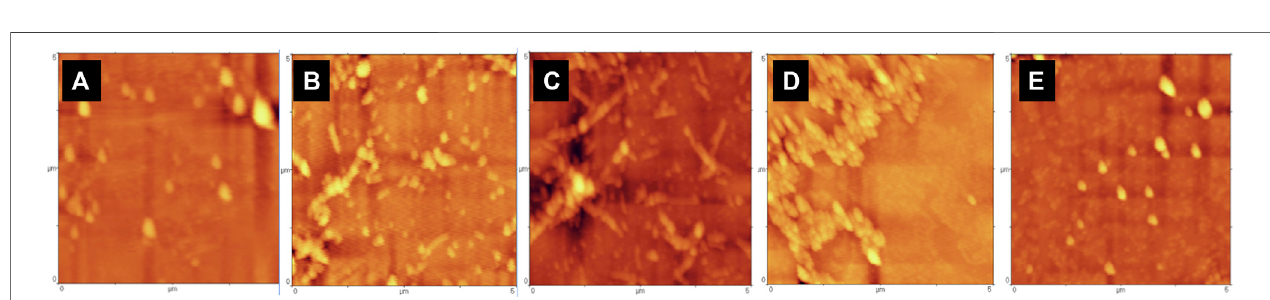
FIGURE10| SDS-andnative-PAGEanalysisofnot-heated,not-treated,andtreated α -synucleinsampleswiththevolatilecompoundsCin,PEA,andTEMEDafter 72 h of incubation. (A) SDS-PAGE results. (B) Native-PAGE results. Gel lanes are as follows: M, marker; 1, not-heated α -synuclein; 2, not-treated α -synuclein; 3, α - synucleintreated with PEA; 4, α -synuclein treated with TEMED; 5, α -synuclein treated with Cin. (C) Color observation ofSDS-PAGE loading buffer upon additionof not- heatedandnot-treated α -synucleincontrolsamplesandthatofsamplesof α -synucleintreatedwithPEA,TEMEDandCin.Onlyinthesampleof α -synucleintreated with Cin, the loading buffer color changes from blue to orange.